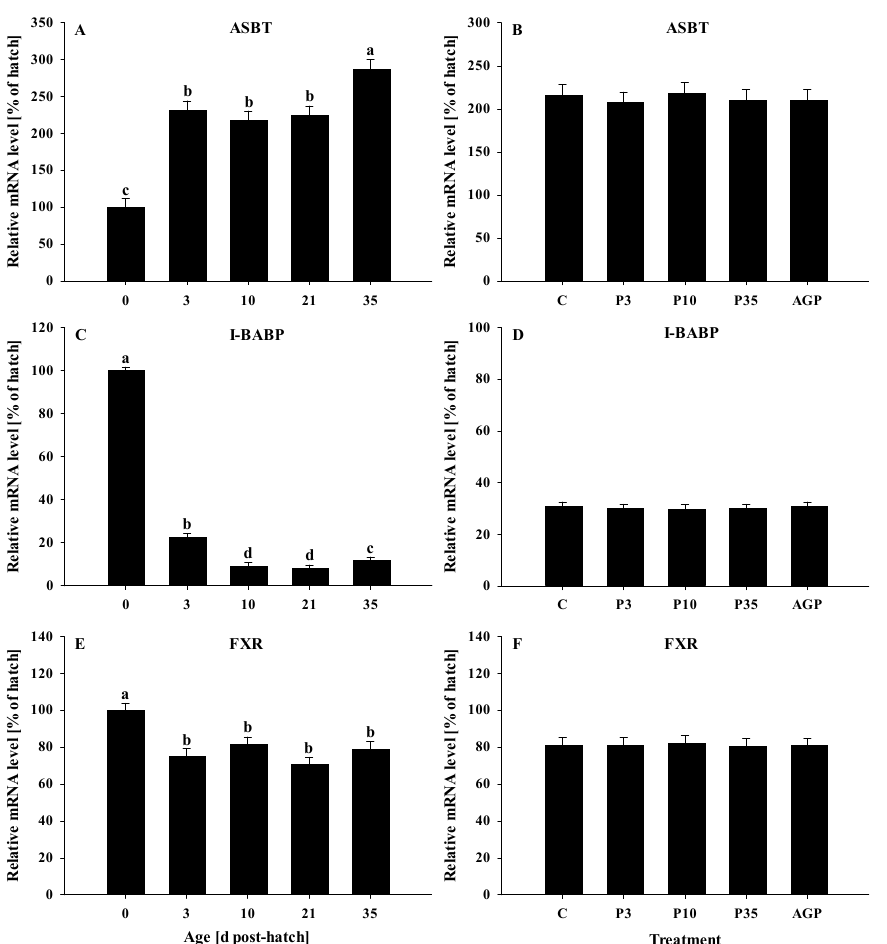
Figure 1. Age and treatment effects on mRNA levels of genes associated with bile acid metabolism in the ileum. Age effects on ( A ) apical sodium-dependent bile acid transporter (ASBT), ( C ) ileal bile acid binding protein (I-BABP), and ( E ) farnesoid X receptor (FXR). Treatment effects on ( B ) ASBT, ( D ) I-BABP, and ( F ) FXR. The expression level of hatch (day 0) was set to 100%, and other values were calculated as a % of the hatch data. Each value represents mean ±SE. Treatments are C, normal water (without supplements) from day 0 to 35 post-hatch; P3, FM in water for first 3 days post-hatch, followed by normal water until day 35; P10, FM in water for first 10 days post-hatch, followed by normal water until day 35; P35, FM in water from hatch to day 35; and AGP, AGP in water from hatch to day 35. a,b,c,d Letters indicate significance ( p < 0.05) between days post-hatch. The mRNA expression of OST α was reduced ( p < 0.0001) from day 0 to 3, remained I-BABP mRNA expression was significantly reduced ( p < 0.0001) from day 0 to constant from day 3 to 21, then increased at day 35; but no OST α mRNA expression dif-